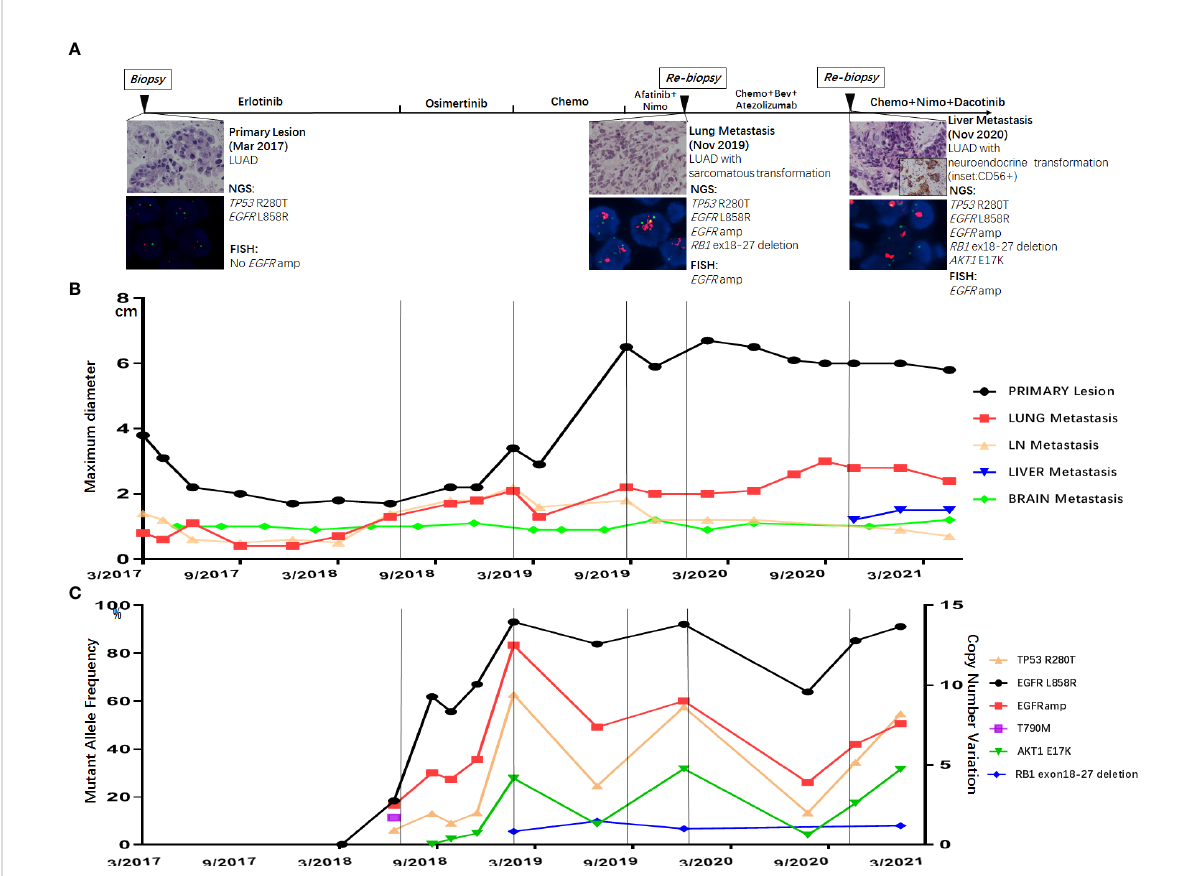
FIGURE 1 (A) Treatment timeline of the patient, histological morphology, and genetic results of three tissue biopsies (primary lesion in March 2017, lung metastasis in November 2019, and liver metastasis in November 2020). Dynamic monitoring of radiological results (B) and circulating tumor DNA using next-generation sequencing (NGS) (C)